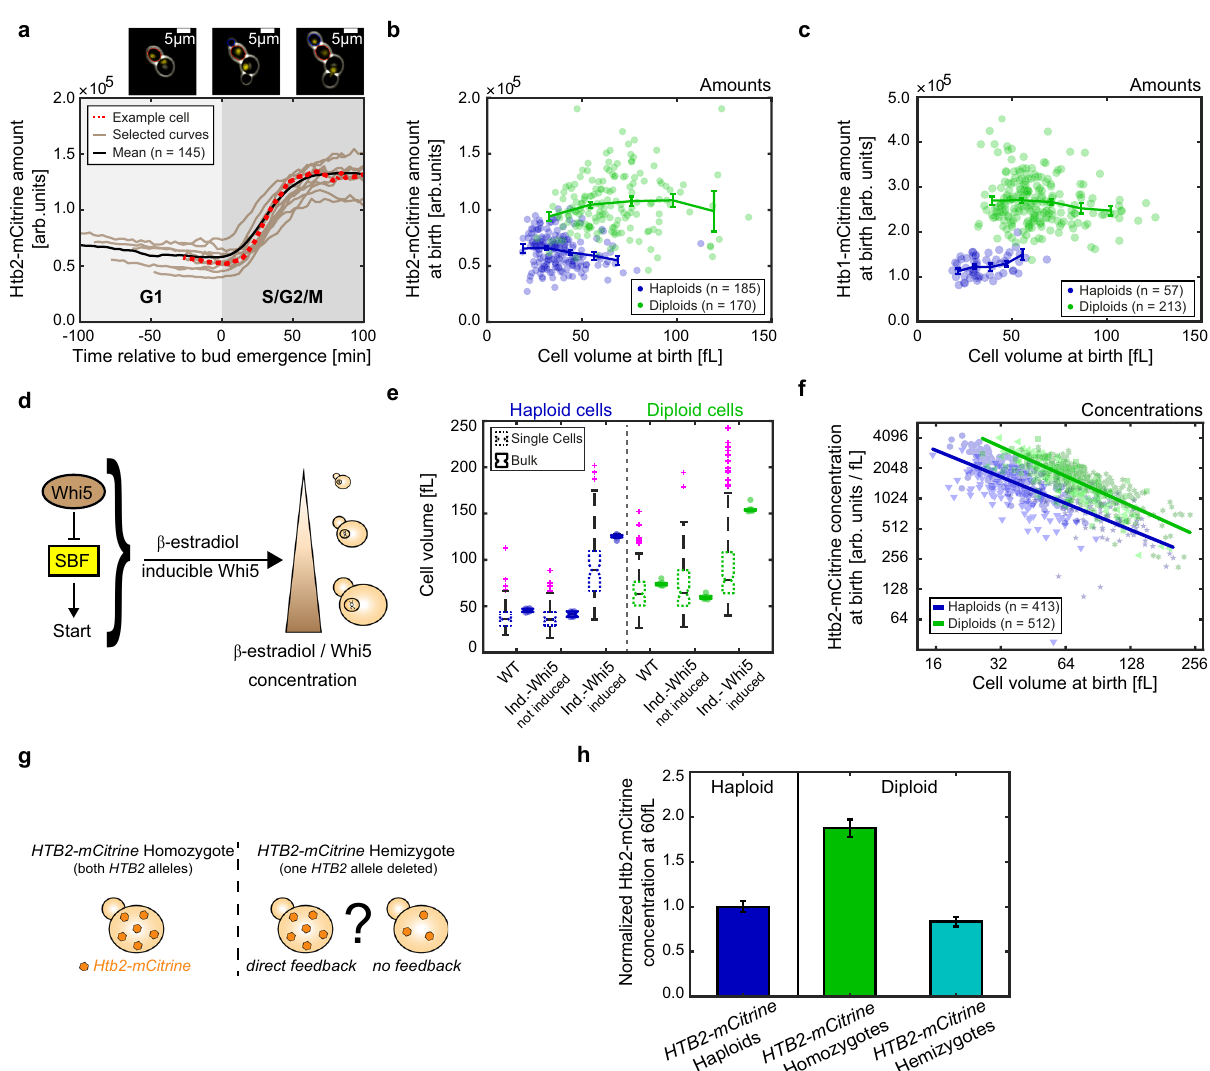
Fig. 1 Htb1/2-mCitrine protein concentrations measured by live-cell fl uorescence microscopy decrease with cell volume and increase with ploidy. a Htb2-mCitrine amounts during the fi rst cell cycle of new-born cells. Red dashed trace highlights data corresponding to the outlined cell shown in the microscopy images (new-born cell: red outline, its bud: blue outline), brown traces show additional randomly selected example curves and the black line shows the mean of n ¼ 145 cells. All traces are aligned at the time of fi rst bud emergence ( t = 0). b Htb2-mCitrine amounts at birth for haploid (blue) and diploid (green) cells as a function of cell volume. Lines connect binned means with error bars indicating standard errors. c Htb1-mCitrine amounts at birth for haploid (blue) and diploid (green) cells as a function of cell volume. Lines connect binned means with error bars indicating standard errors. Note that the fl uorescence intensities for Htb2 and Htb1 are not directly comparable due to differences in the microscopy settings. d Whi5 controls cell volume in a dose-dependent manner. To manipulate cell volume, WHI5 is expressed from a β -estradiol-inducible promoter. Higher β -estradiol concentrations result in increased mean cell volumes. e Distribution of cell volumes for non-inducible (WT) and inducible haploids (blue) and diploids (green) measured at birth in HTB2-mCitrine single cells with live-cell fl uorescence microscopy, or mean cell volumes in bulk populations of cells with untagged HTB2 measured with a Coulter counter. Colored boxes highlight the 25- and 75-percentiles, whiskers extend to ± 2 : 7 σ of the distributions and colored crosses highlight outliers. ¼ 185, n not ind : ¼ 120, n ind : ¼ 108, n WT ¼ 170, Black, horizontal lines indicate the median between single cells for single cell measurements ( n WT haploid haploid haploid diploid ¼ 99, n ind ¼ 243) or the median of population means across seven biological replicates for bulk measurements. Notches indicate the 95% n not ind : diploid diploid con fi dence interval of the median. Haploid cells were induced with 30 nM β -estradiol, diploid cells with 50 nM. f Htb2-mCitrine concentrations of non- inducible and inducible haploids and diploids as a function of cell volume are shown in a double-logarithmic plot. Individual data points for the different conditions are shown in blue for haploids (triangles for 0 nM, circles for WT, and stars for 30 nM) and green for diploids (triangles for 0 nM, squares for WT, and stars for 50 nM). Lines show linear fi ts to the double-logarithmic data, used to calculate the VDPs. g Illustration of the impact of potential feedback mechanisms on the concentration of Htb2-mCitrine concentration in a HTB2-mCitrine/htb2 Δ hemizygous diploid compared to a HTB2-mCitrine homozygous diploid. h Htb2-mCitrine concentrations at 60 fL, estimated from the linear fi t to the double-logarithmic dependence of concentration on cell volume, for haploids (blue bar, fi t through n ¼ 413 cells), HTB2-mCitrine homozygous diploids (green bar, n ¼ 512 cells), and HTB2-mCitrine/htb2 Δ hemizygous diploids (teal bar, n ¼ 266 cells), normalized on the concentration at 60 fL in haploids. Error bars are derived by error propagation of the 95% con fi dence interval of the linear fi t at 60